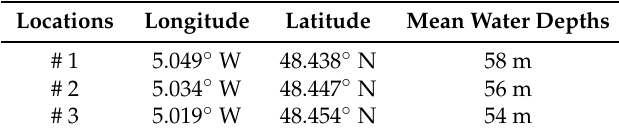
Table 1. Characteristics of locations #1, #2 and #3 (Figure